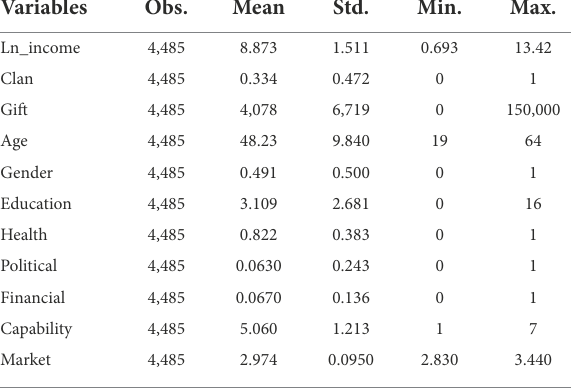
TABLE 2 Summary statistics.